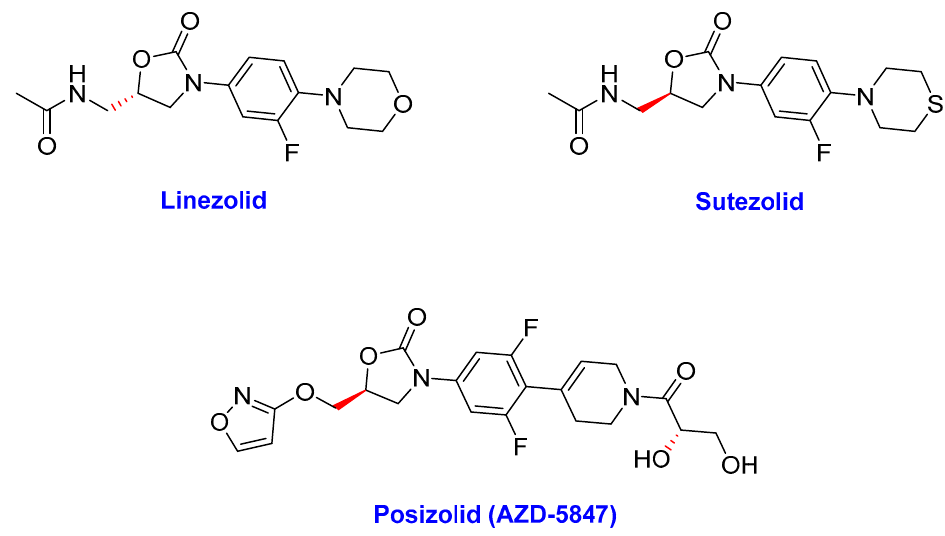
Figure 4. The chemical structures of oxazolidinones currently in TB clinical trials. (i) Linezolid